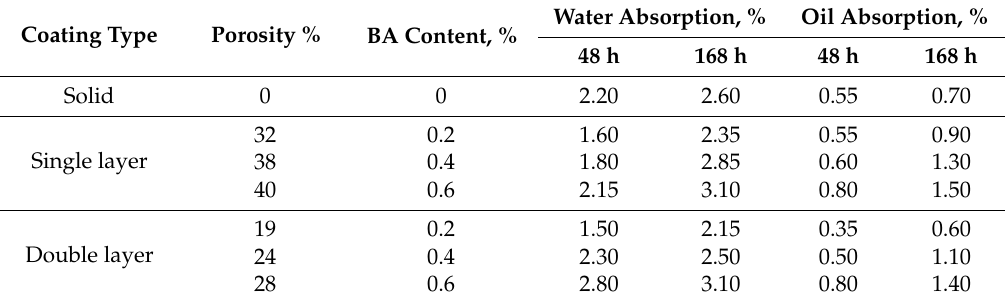
Figure 3. Dependence of density of the coatings with PVC on the content of BA. Table 1. Results of porosity, liquid absorption of PVC coatings.